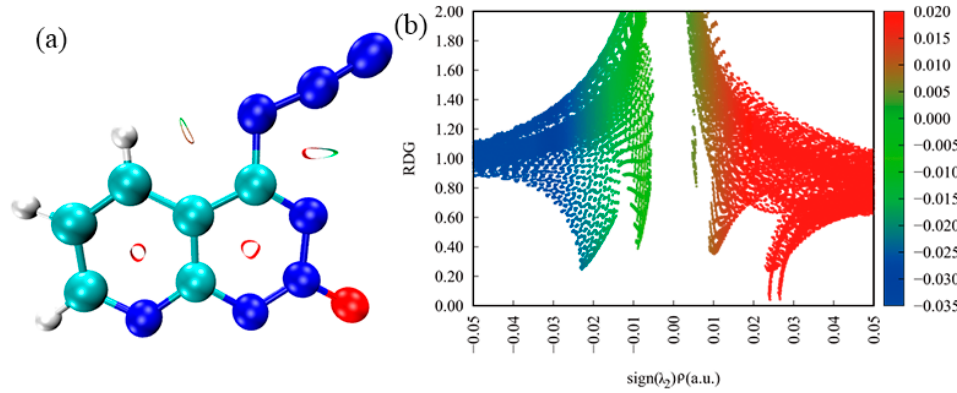
10 of 14 Figure 8. RDG map and NCI plot of gradient isosurface of Crystal a : ( a ) noncovalent interactions analyses; ( b ) scatter graph. As shown in Figure 9a, four colourful circles are located in the NCI plot of Crystal b . It is of particular concern that a dark red circle is in the centre of each six-membered ring, indicating that a strong repulsion exists in the molecular structure of Crystal b . In Figure 9b, the blue region is a slender band at − 0.05 < sign(𝜆 (cid:2870) ) 𝜌 < − 0.03, which indicates that there are strong intermolecular interactions, such as hydrogen bonds, in Crystal b . When − 0.03 < sign(𝜆 (cid:2870) ) 𝜌 < 0.01, there is a green region with two obvious spikes that signifies